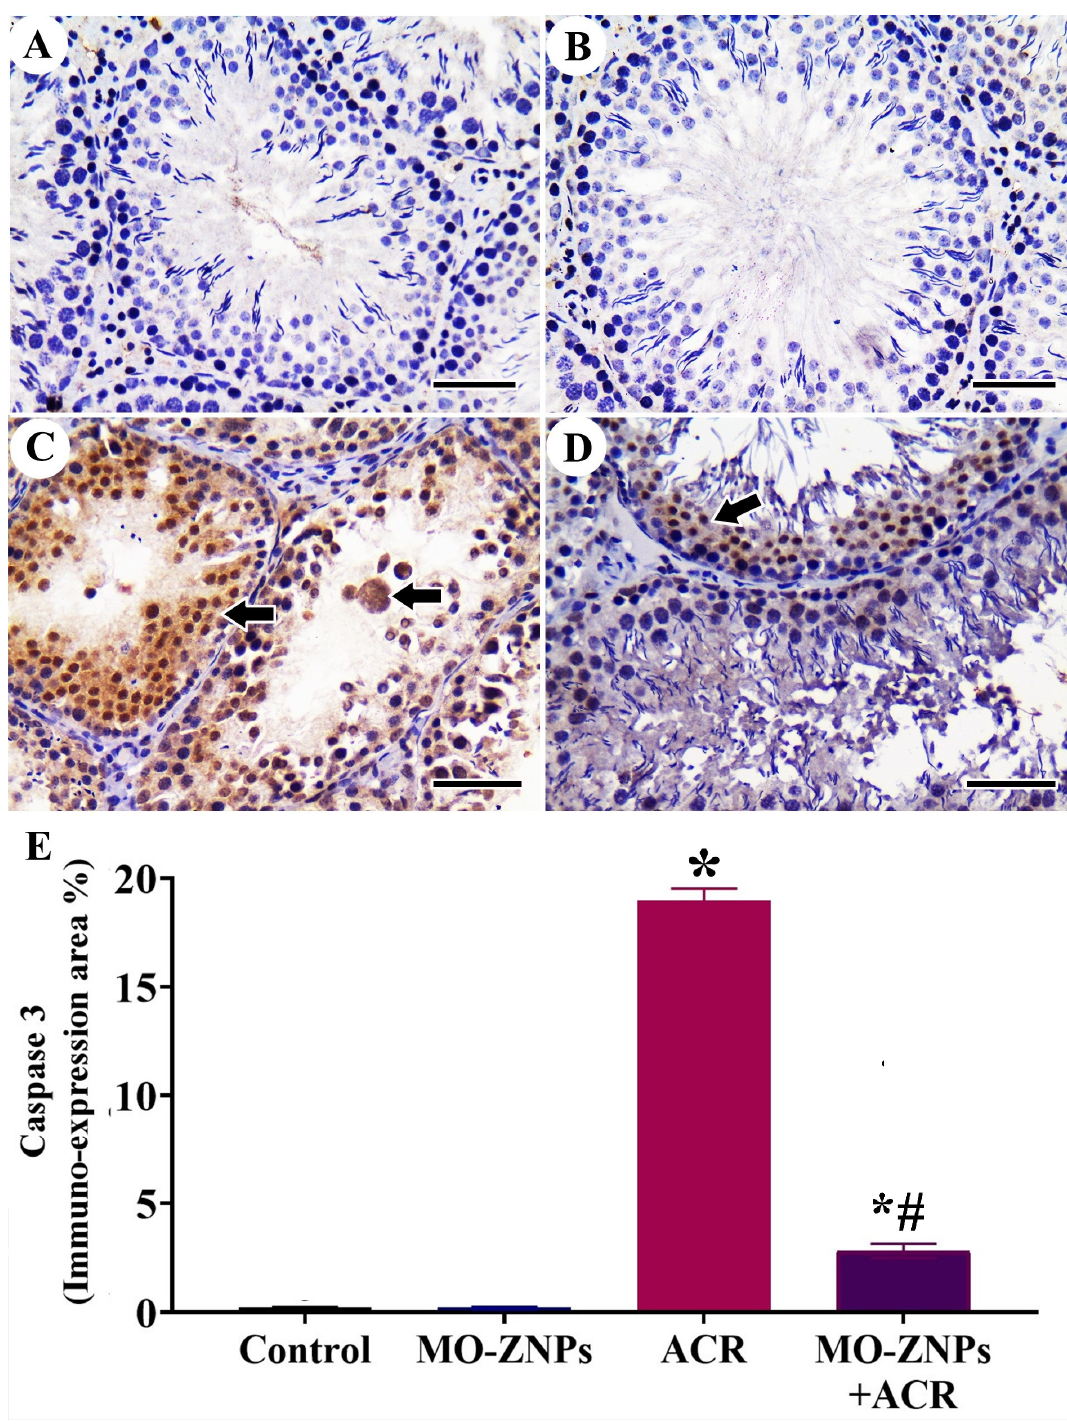
Figure 4. Immunohistochemical staining of rat testis by Caspase-3: ( A ) Control group; ( B ) ZnO group; ( C ) ACR group showing a high number of Caspase-3 reacted nuclei (arrows); ( D ) ACR+ MO-ZNPs group. Scale bar = 50 µm; ( E ) Changes in the immunohistochemical expression and quantitation of Caspase-3 in rat testis of the different experimental group. Bars represent the mean ± SE. n = 10 replicates/treatment. * p < 0.05 vs. control. # p < 0.05 vs. ACR.